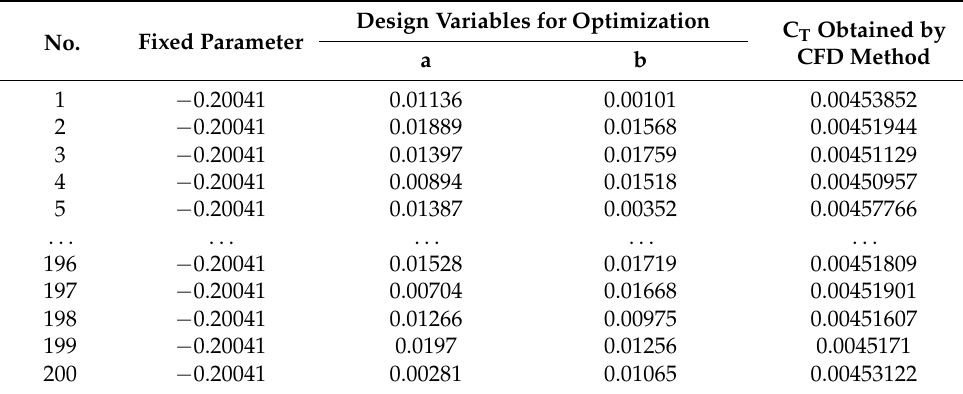
Figure 10. Sample space distribution for two − dimensional space obtained using the Opt LHD algorithm. Table 3. Sample points and the corresponding C T value.